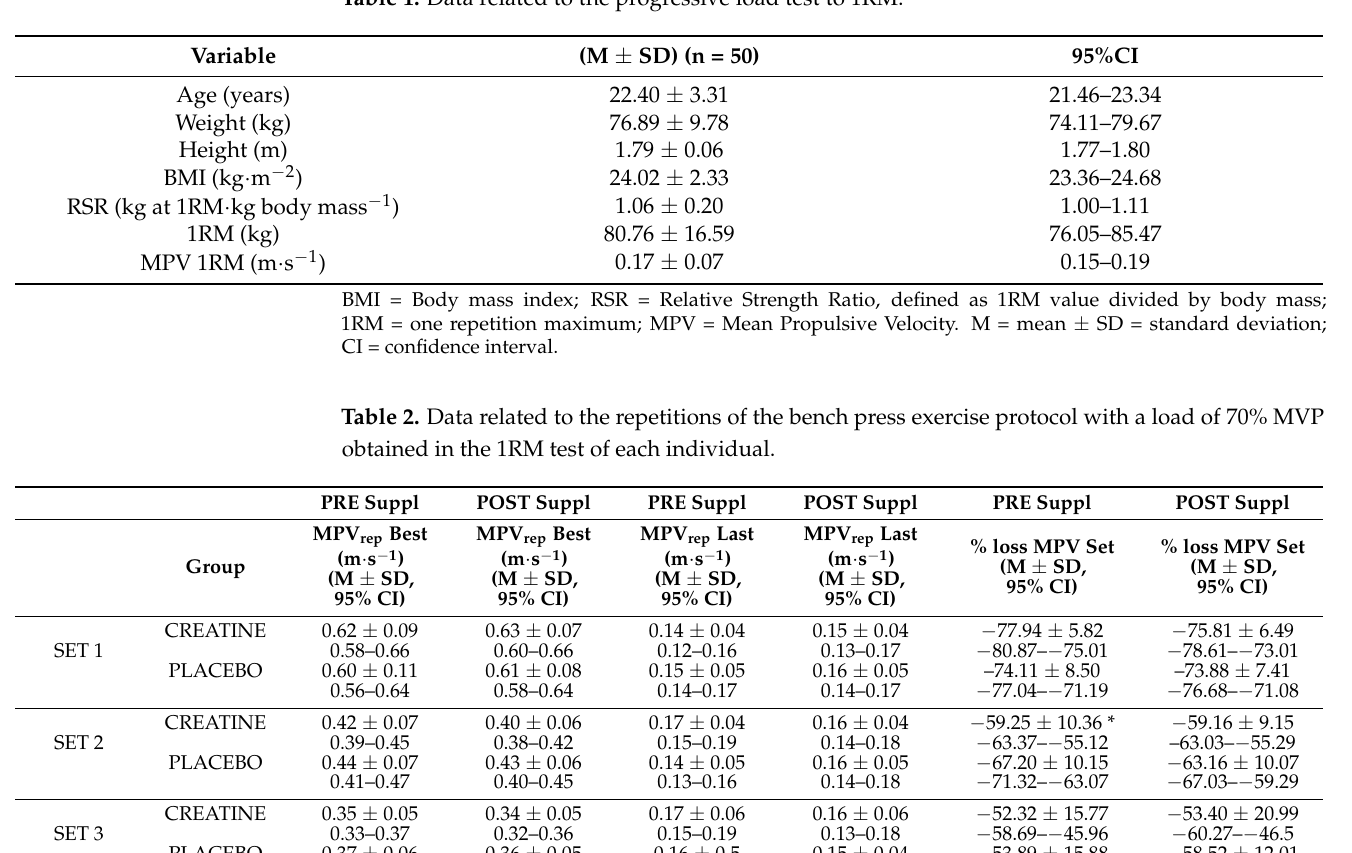
Table 1. Data related to the progressive load test to 1RM.